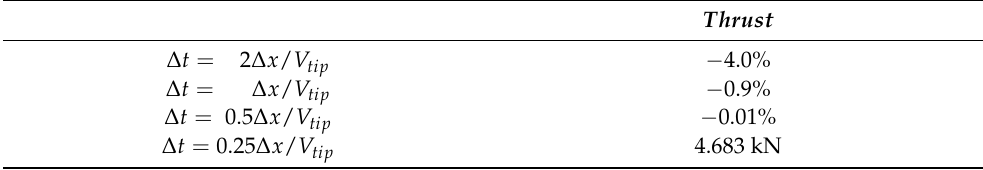
Table 8. Variation of thrust [kN] with increasing time-step ∆ t [s]. Reference thrust corresponds to minimum value ∆ t = 0.25 ∆ x / V tip